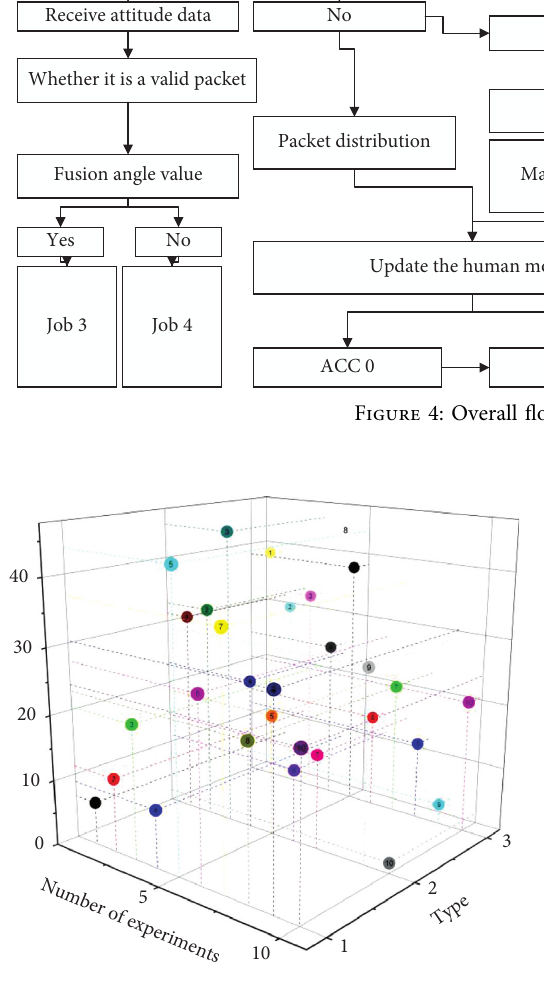
6: Segmentation of the calibration